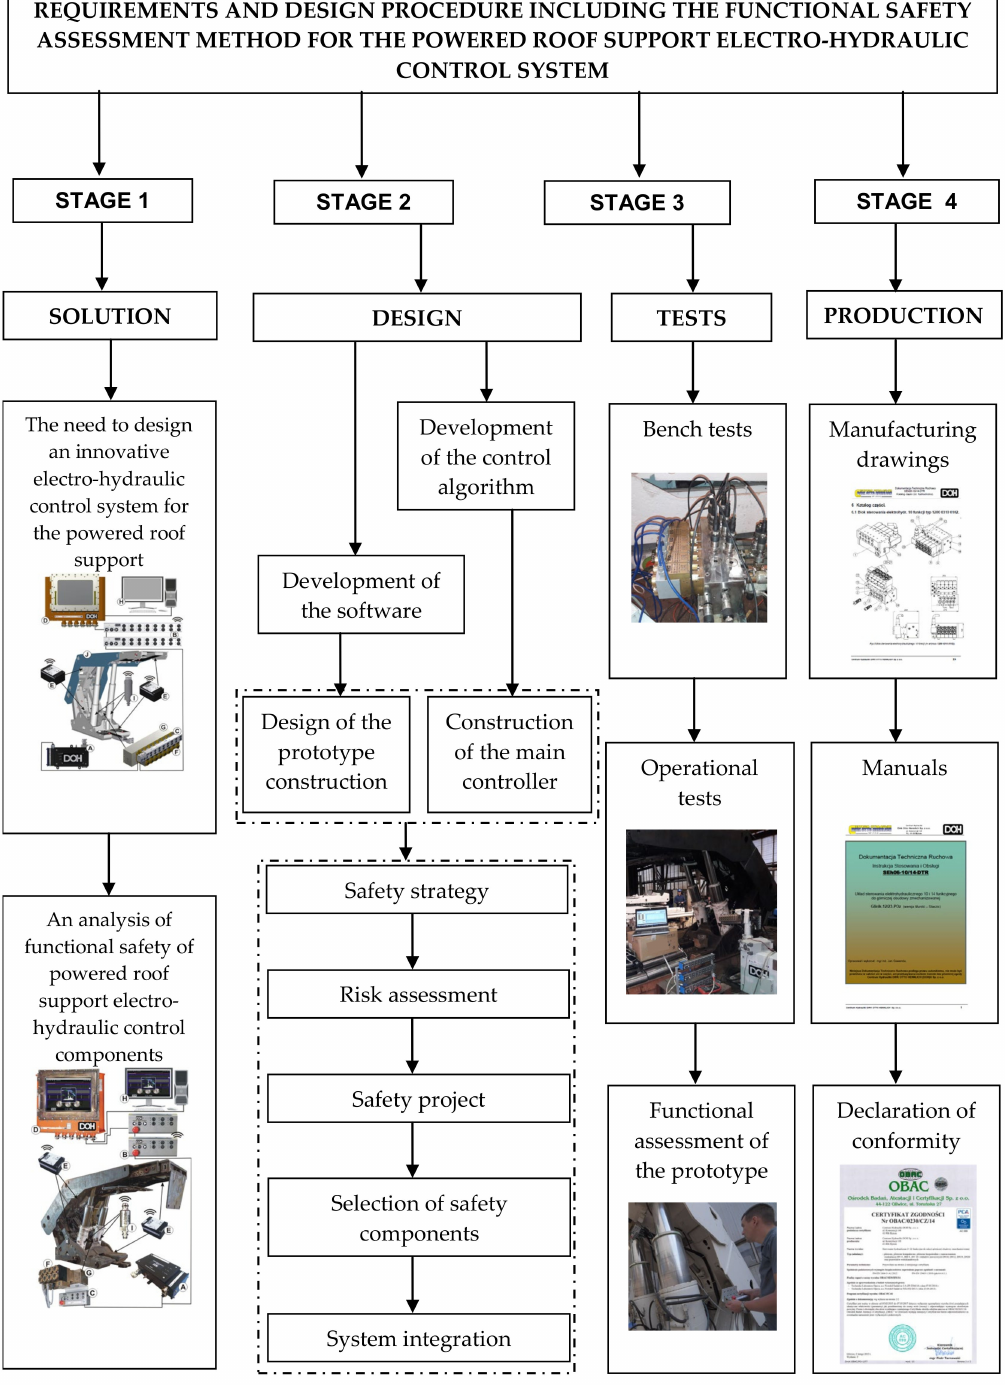
Figure 8. The procedure together with the procedure for testing and evaluation for the introduction of an electro-hydraulic control system and a visualisation system for underground mine